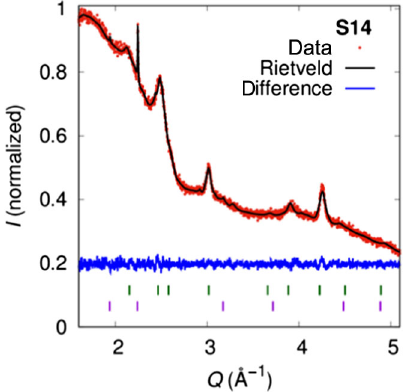
FIG. 8. Rietveld refinement of PXRD pattern of cobalt ferrite NPs. The green and purple vertical lines correspond to the Bragg reflections of spinel cobalt ferrite [73] and of the sodium chloride structure [74],